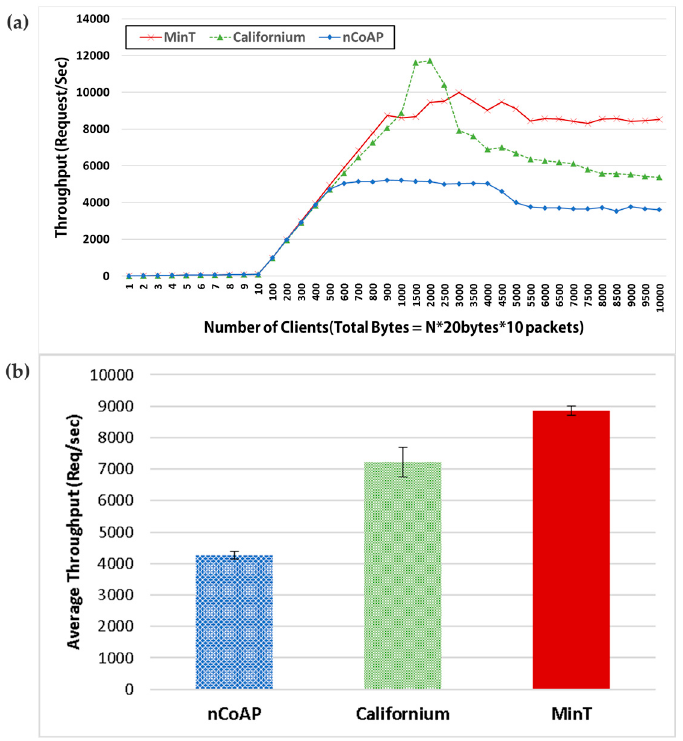
Figure 16. (a) Throughput and (b) average throughput with MinT, Californium, and nCoAP(SE).